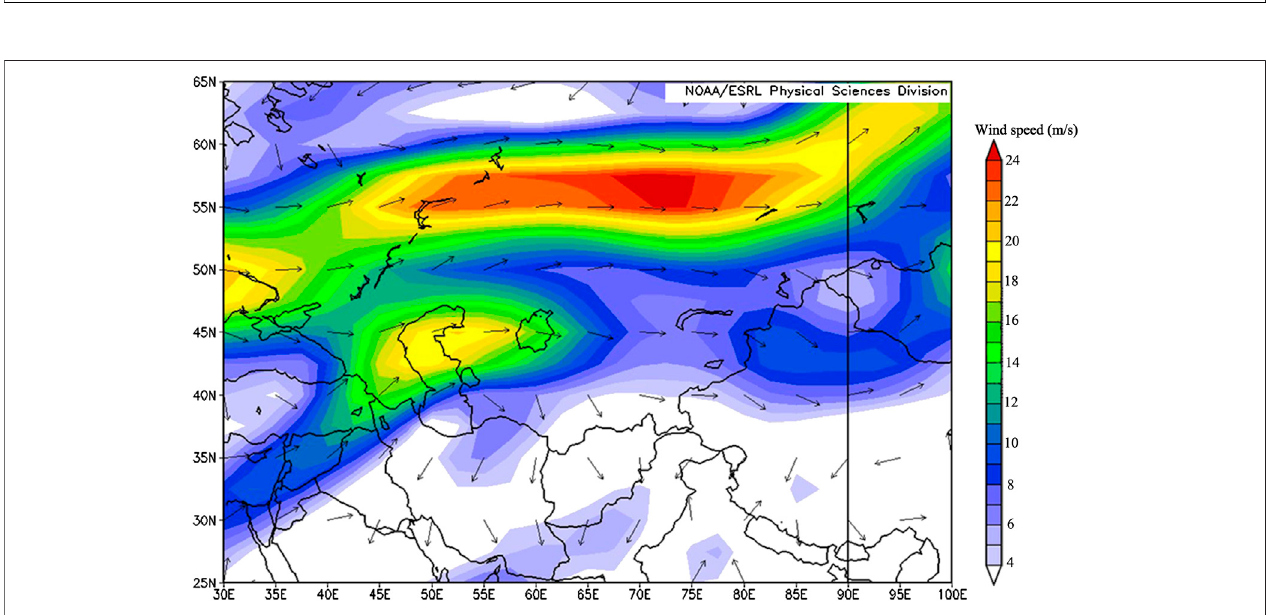
FIGURE 8 | The wind stream of the 700 hPa isobaric surface (August 5 – 7, 2008) over Glacier No. 72 and the surrounding regions, based on NCEP/NCAR reanalysis (shadowing indicates the wind speed, and arrows indicate the wind direction).